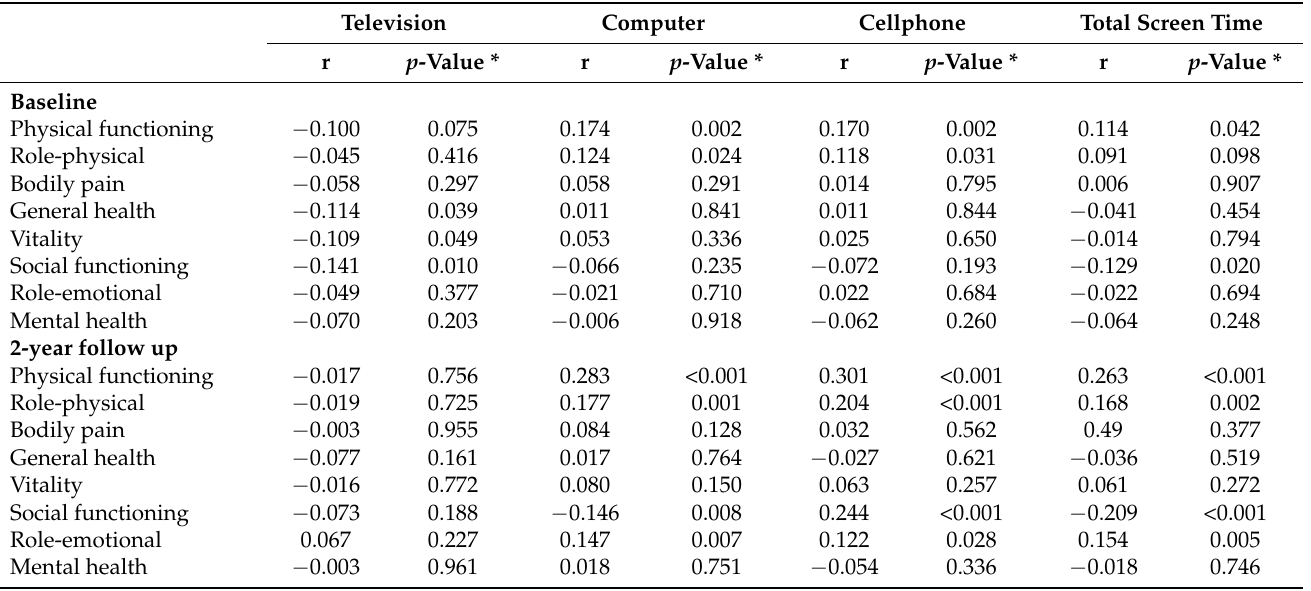
Table 2. Correlation between screen time at different devices and HRQoL domain scores in community-dwelling adults (n =